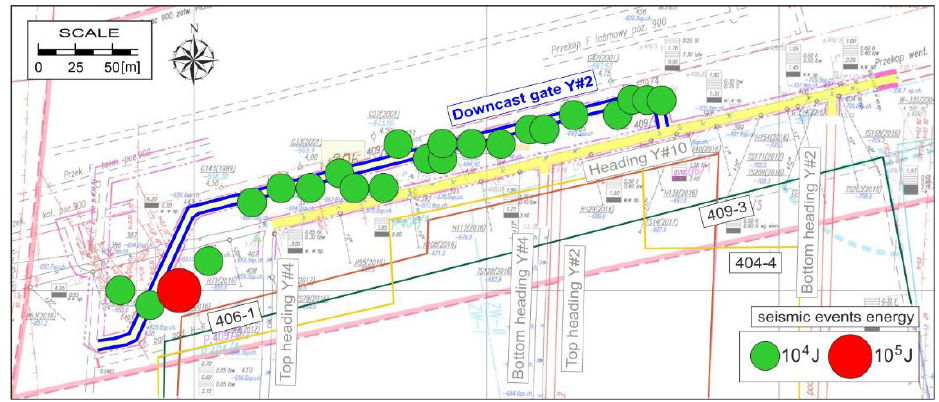
Figure 4. Distribution of seismic events with energy E ≥ 10 4 J during the drifting of downcast gate Y#2.